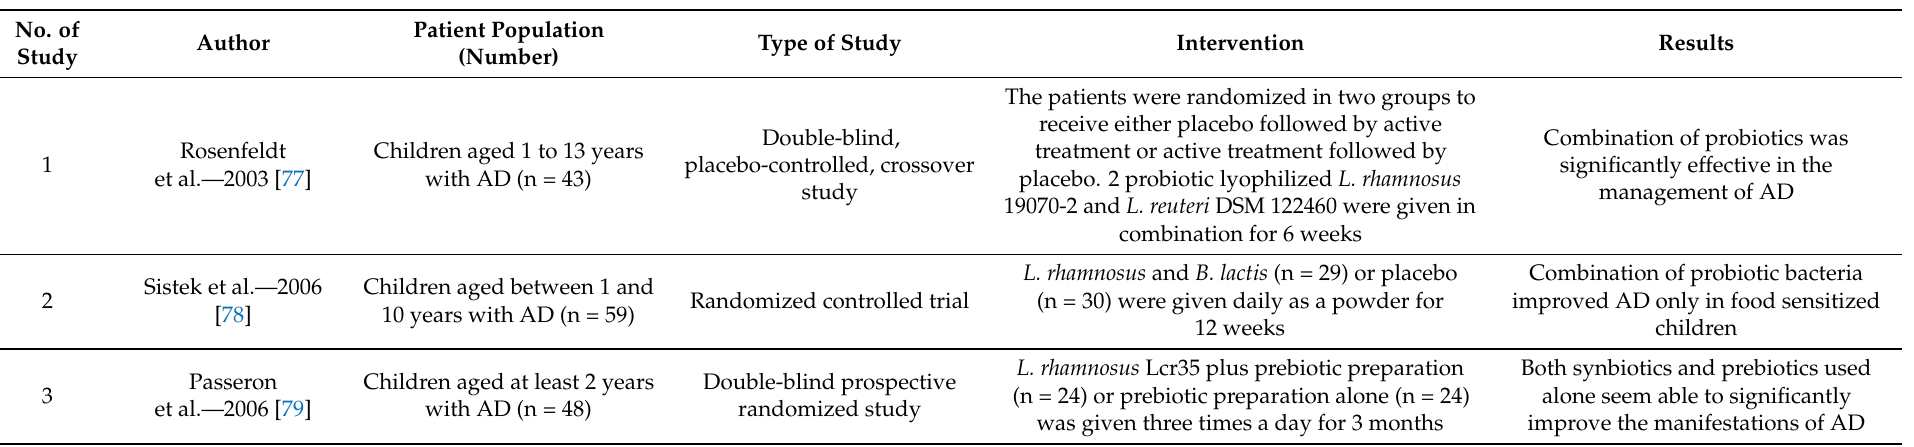
Table 4. Pre- and probiotics in the treatment of AD in